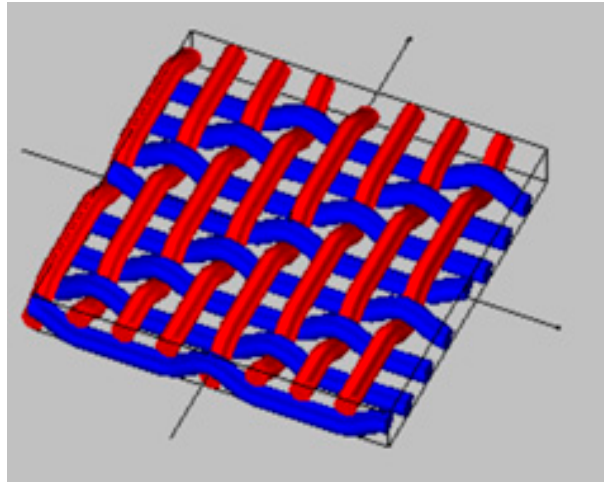
Figure 1. The basic structure of woven fabric with twill 3/1 structure. To adapt with the twill 3/1 structure, a geometrical hole is defined as indicated in Figure 2. The nominal diameter of hole d and perforation ratio σ of woven fabrics are defined as follows: